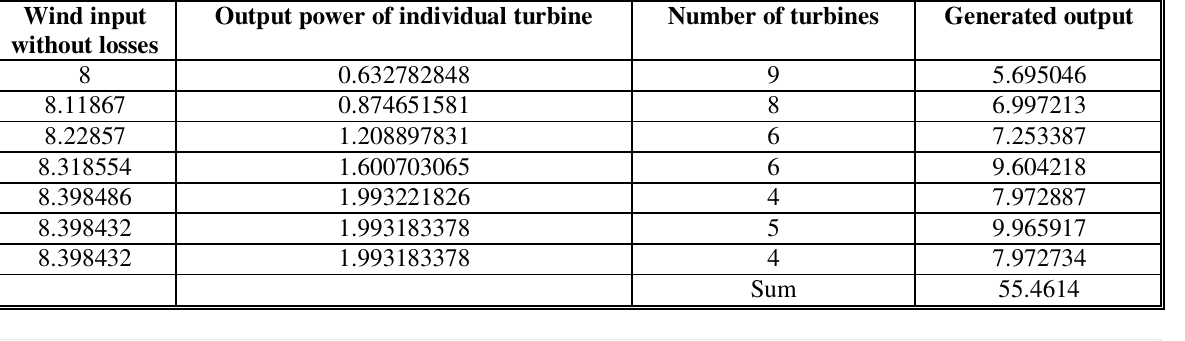
Fig. 10. Turbine quantity and original wind input of continuous spaced layout, turbines with different hub height Table 9: Wind input, power output of single wind turbine, total turbines in each row and actual power generation at different wind speed due to different hub height